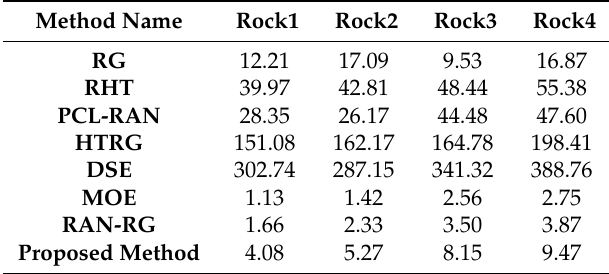
Table 6. Execution time for all